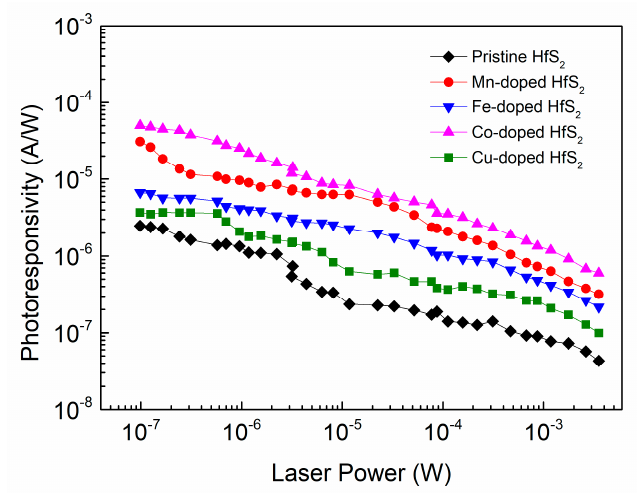
Figure 8. Photoresponsivity of the pristine, Mn-, Fe-, Co-, and Cu-doped HfS 2 crystals as a function of laser power.